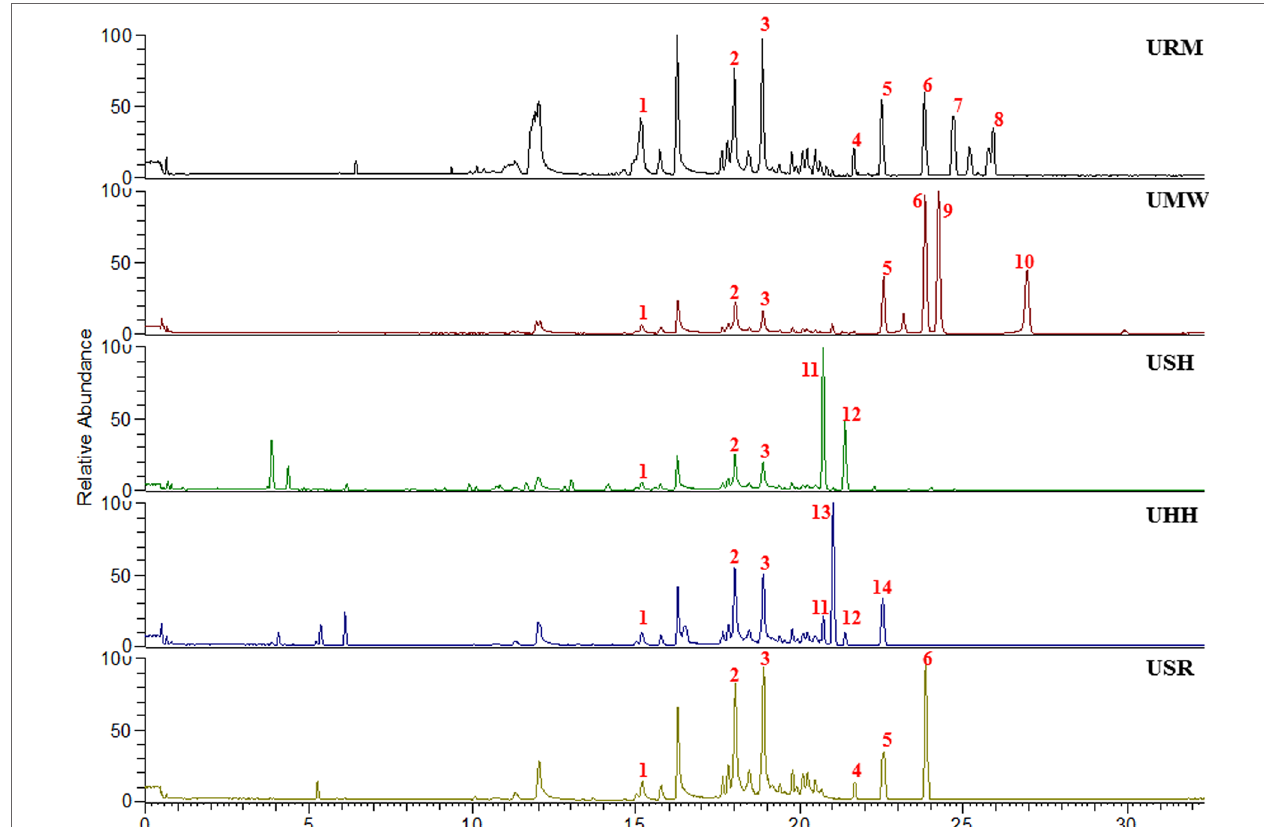
FIGURE 1 | The HPLC fingerprints of five different Uncaria Stem with Hooks (UHs)